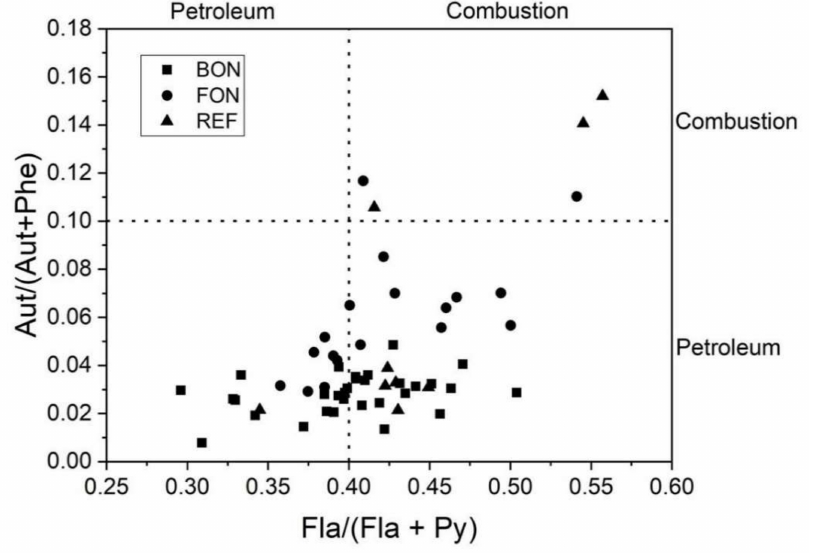
Figure 11. Cross plots of PAH diagnostic ratios Ant / (Phe + Ant) vs. (Fla / (Fla + Py) identifying sources of PAHs in all sediments layers of the Fontespina site (FON), the Bonaccia site (BON) and the reference site